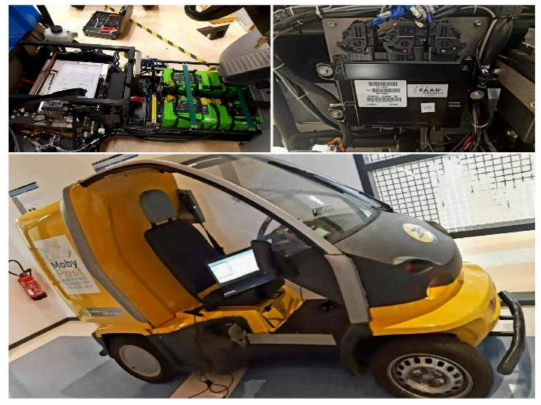
Figure 11. Moby Post FCHEV.